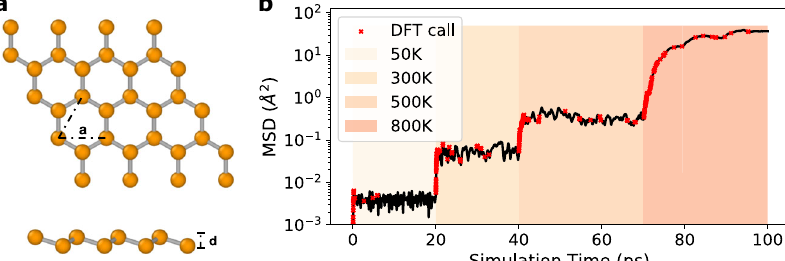
Fig. 2 Bayesian active learning of stanene. a Pristine stanene, top view and front view. b Atomic mean square displacement (MSD) of the on- the- fl y training trajectory. The solid black line shows the MSD of the 32 atoms, the color blocks indicate time intervals corresponding to different temperatures, and the red dots represent events when DFT calculations are called as the uncertainty predictions exceed the data acquisition decision threshold and new data are added to the training